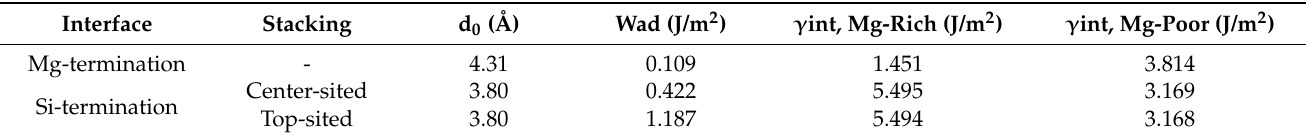
Table 2. The interfacial spacing of complete relaxation of Mg 2 Si (001)/Gr (0001) interfaces and the corresponding work of adhesion and interfacial